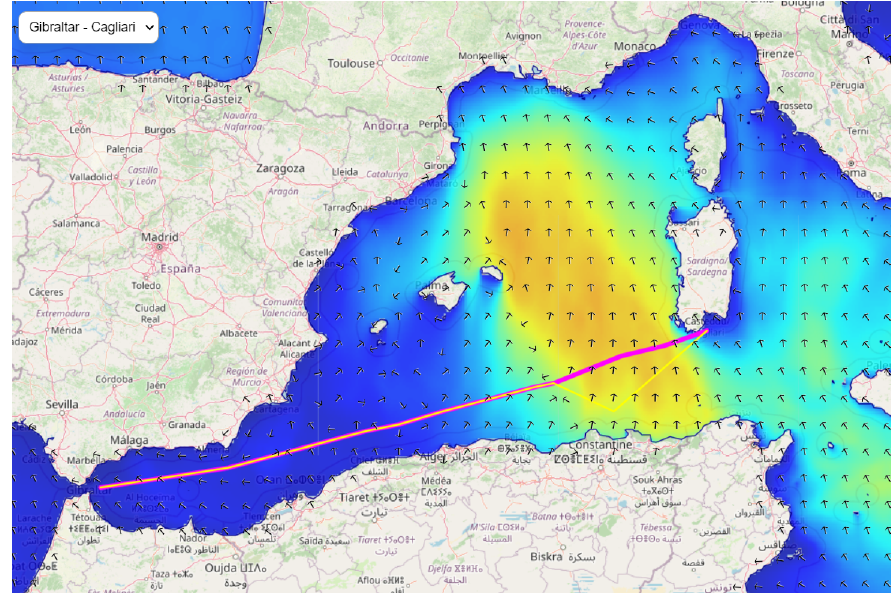
Figure 4. Alternate route recommendation on route Gibraltar–Cagliari.